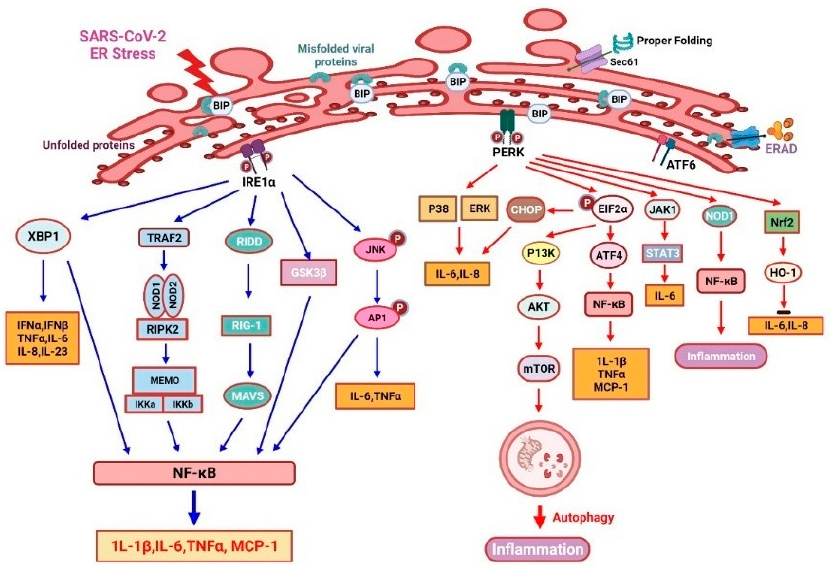
Figure 3. UPR-related inositol-requiring enzyme 1 α (IRE-1 α ) and protein kinase R-like endoplasmic reticulum kinase (PERK)-mediated inflammation response in COVID-19.